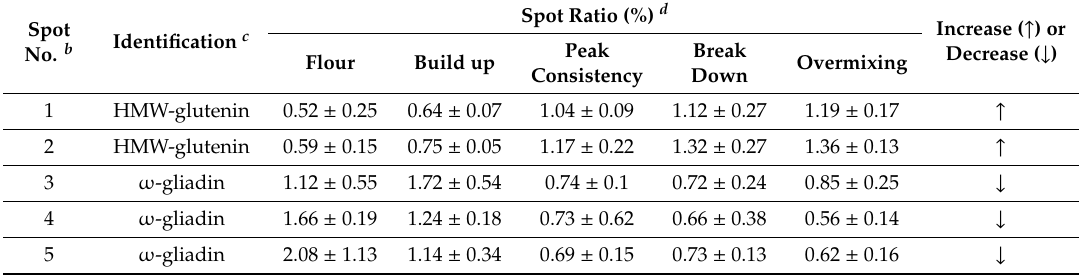
a Spots were detected by 2dimensional fluorescence di ff erence gel electrophoresis (2D-DIGE), significant di ff erences ( p < 0.05, n = 4) were determined by the ANOVA test. Proteins with volume ratios > 2.0 are described. b These spot numbers correspond to the spot numbers in Figure 9a. c The identification of each protein was estimated based on the report of Dupont et al. [26]. d Values are means ± standard